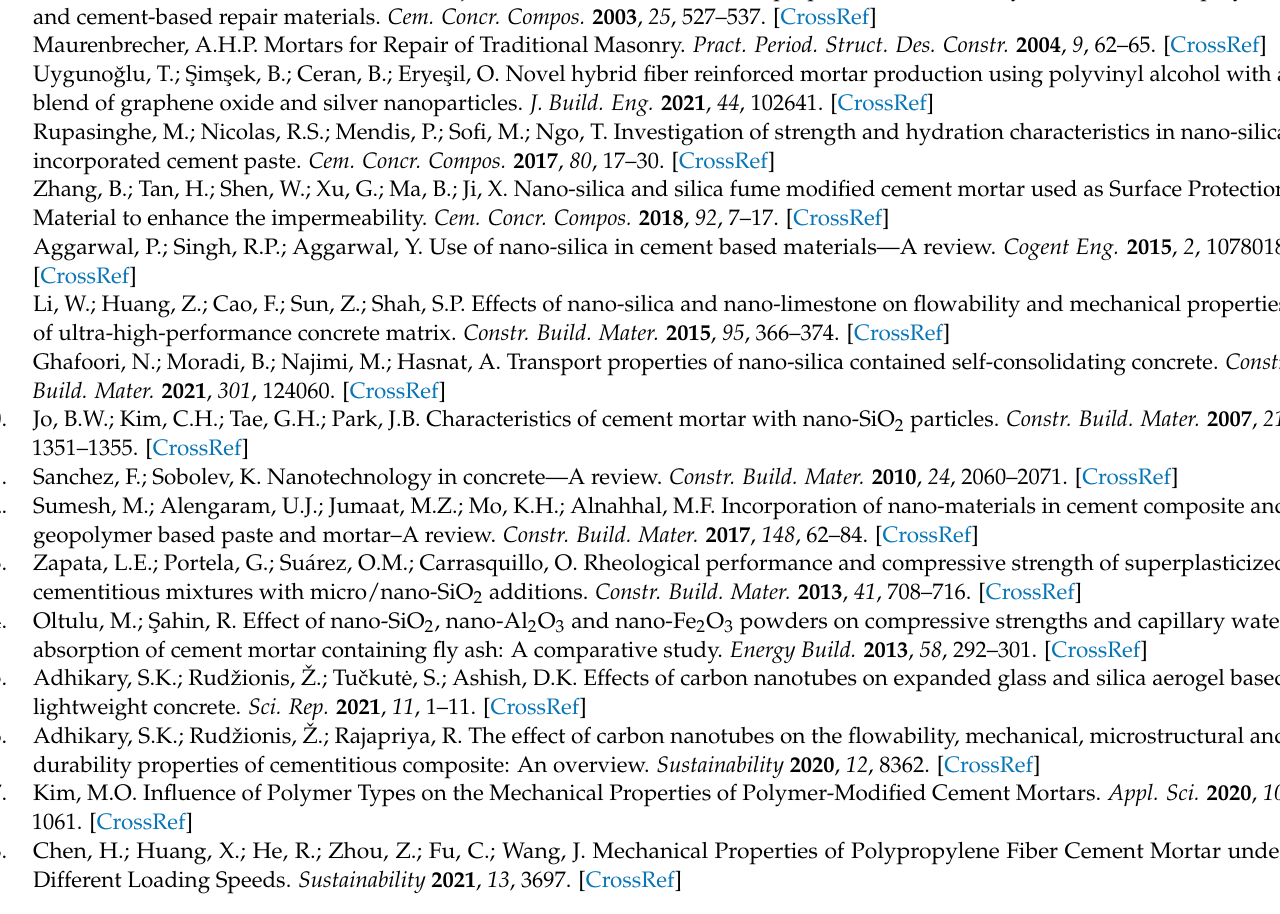
the control mix design, Table S2: The β coefficient. Table S3: The β